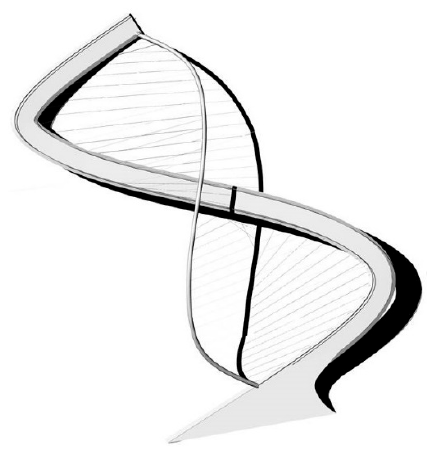
Figure 14. Salford Footbridge (photo courtesy of José Romo).